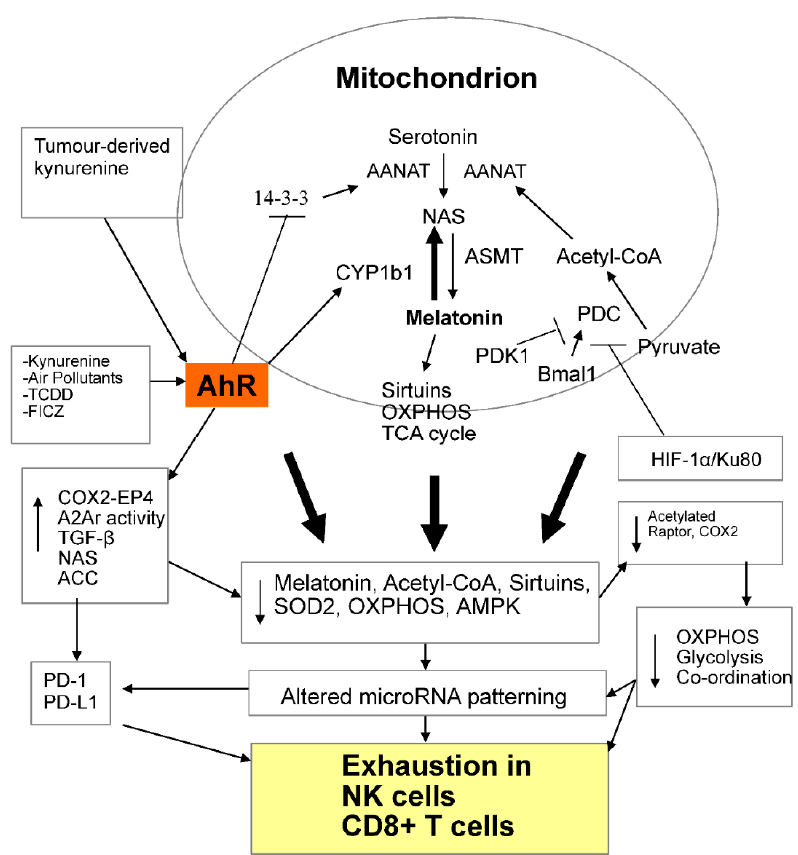
Figure 1. Shows how AhR ligands, such as air pollutants, FICZ, TCDD and kynurenine, including tumour derived, activate the AhR to modulate mitochondrial metabolism, partly via the regulation of the melatonergic pathway. The melatonergic pathway is shown in the mitochondrion, but is also present in the cytoplasm. AhR activation drives a number of processes and factors underpinning exhaustion and tumour survival, including the COX2/PGE2/EP4, adenosine A2Ar, TGF- β , ACC and NAS. In NK cells and CD8+ T cells, factors inhibiting acetyl-CoA, such as HIF-1 α /Ku80 and PDK1 inducers, will inhibit the TCA cycle, OXPHOS and the co-ordination of OXPHOS with glycolysis, in association with a decreased acetylation of COX2. OXPHOS and glycolysis are co-ordinated by a decreased acetylation of Raptor within the mTORC1 complex. The changes in mitochondrial function driven by decreased melatonin, acetyl-CoA, Sirtuins, SOD2, OXPHOS and AMPK will modulate gene expression, partly via levels of ROS production and the associated changes in miRNAs expressed. Altered miRNA patterning will drive variations in the classical immune checkpoint inhibitors, such as the PD-1 suppression by miR-138. Variations in such acetyl-CoA, melatonergic pathway regulation of OXPHOS and glycolysis will occur in the array of immune cells within the tumour microenvironment, with the dynamic intracellular and intercellular interactions of these cells driven by variations in metabolic regulation. Other factors may also ‘backward’ convert melatonin to NAS, including activation of the P2Y1 and mGluR5 receptors, as well as O-demethylation, which are not shown for clarity. The processes highlighted in the figure indicate an important AhR role in the regulation of mitochondrial function. However, the temporal and functional specifics of this await determination in the different cells of the tumour microenvironment, including the interactions of AhR, O-GlcNAcylation, acetyl-CoA and melatonergic pathway. The interactions of AhR effects on mitochondrial function with wider AhR effects on transcription in the different cells of the tumour microenvironment will also be important to determine. Arrows indicate increases/induces; T-arrows indicate suppresses. Abbreviations: AANAT: aralkylamine N-acetyltransferase; ACC: acetyl-CoA carboxylase; acetyl-CoA: acetyl-coenzyme A; AhR: aryl hydrocarbon receptor; AMPK: AMP-activated protein kinase; ASMT: acetylserotonin methyltransferase; CD8+: cluster of